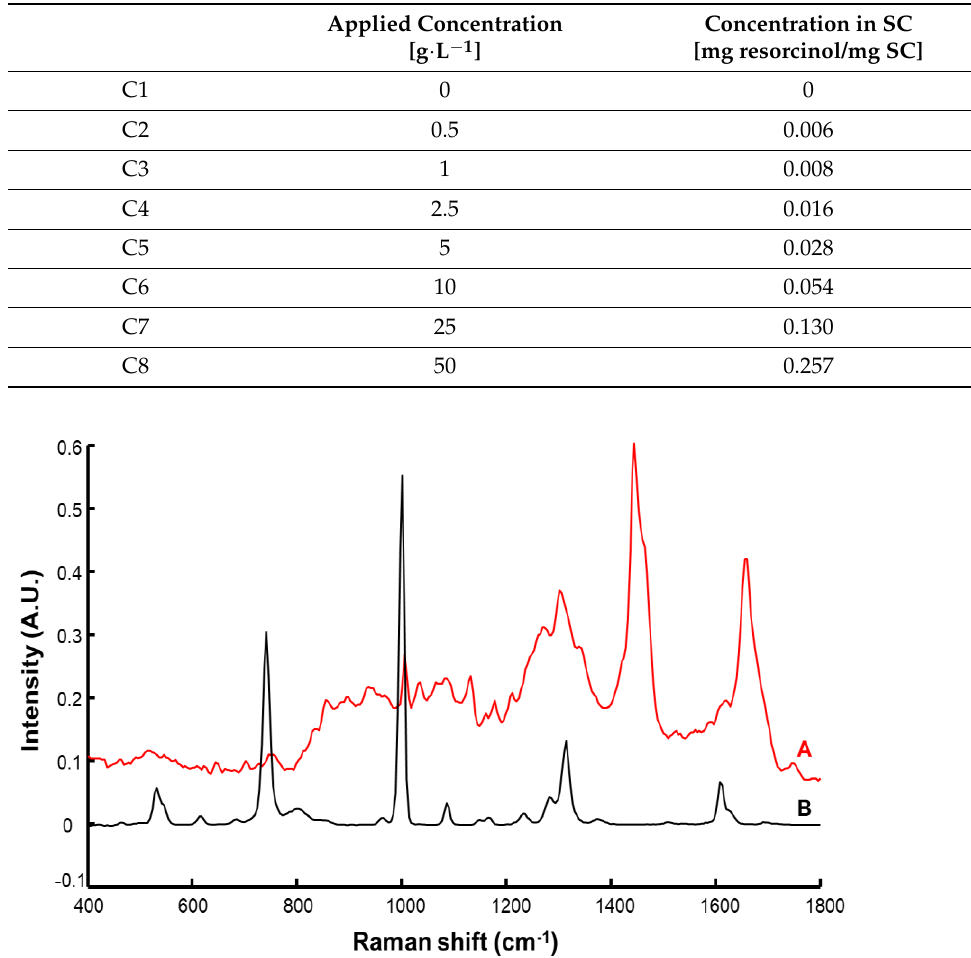
Figure 3. Raman spectra of control stratum corneum (A) and pure resorcinol (B). Spectra are offset for clarity . Table 2. Raman band assignments in SC [46 – 49].